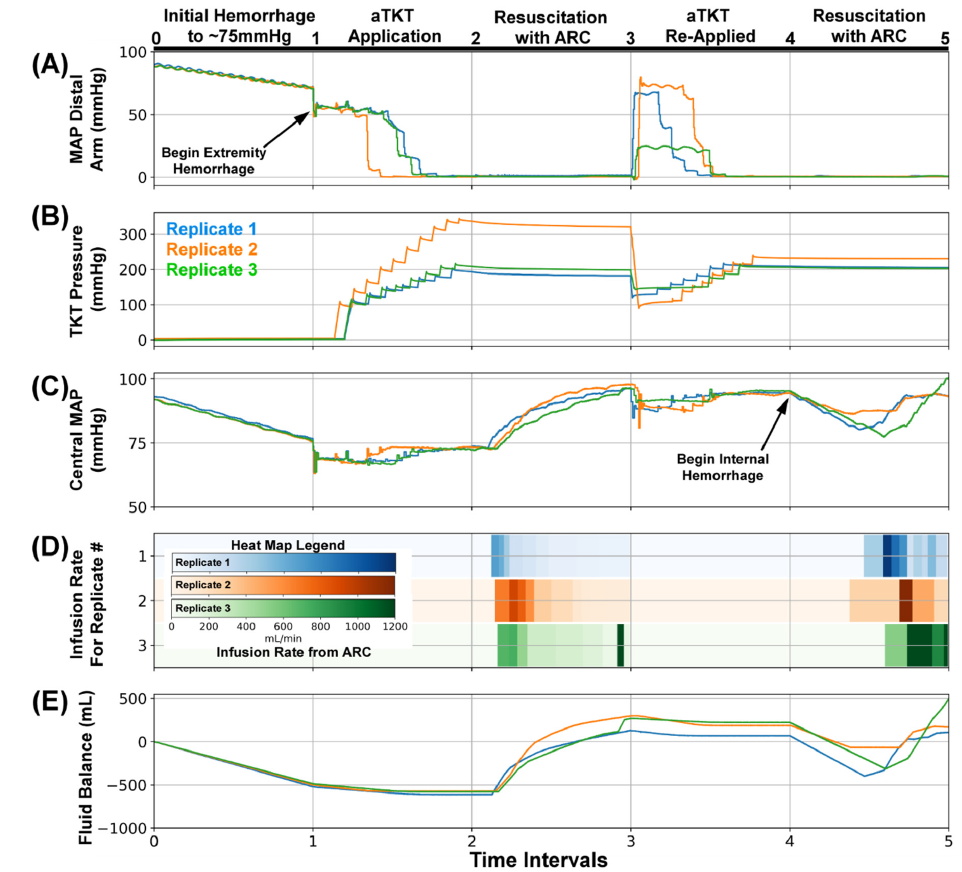
Figure 8. SACM Testing Scenario #4. After (0–1), the initial hemorrhage reduced blood pressure